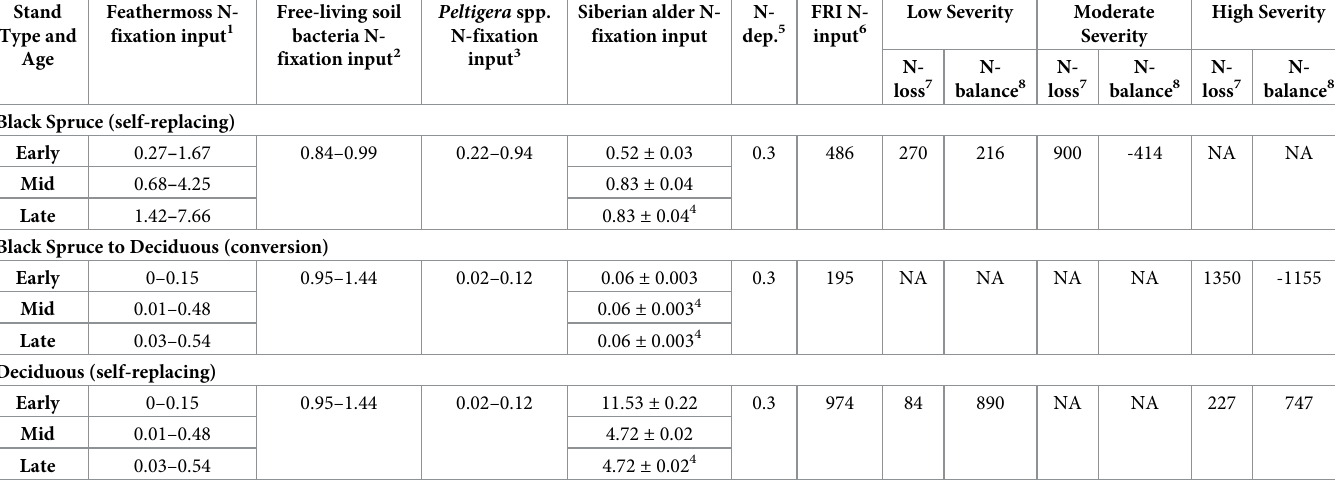
Table 3. Estimates of post-fire N-balance by stand type and fire severity. Feathermoss N-fixation input (kg N ha -1 yr -1 ), free-living soil bacteria N-fixation input (kg N ha -1 yr -1 ), Peltigera ssp. N-fixation input (kg N ha -1 yr -1 ), Siberian alder N-fixation input (kg N ha -1 yr -1 ), and N-deposition (kg N ha -1 yr -1 ) are shown by stand type